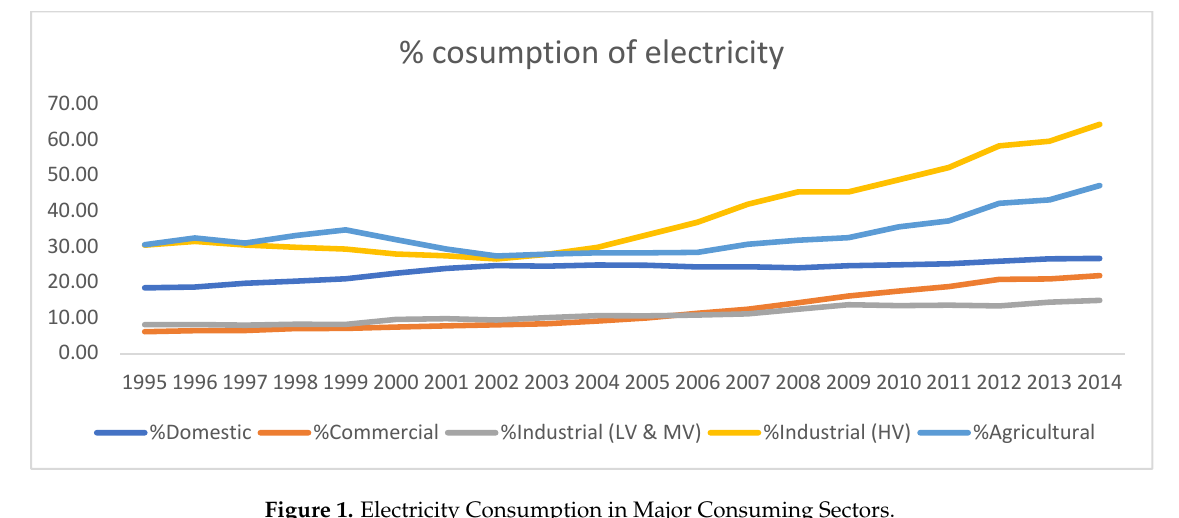
Figure 1: Electricity Consumption in Major Consuming Sectors Figure 1. Electricity Consumption in Major Consuming